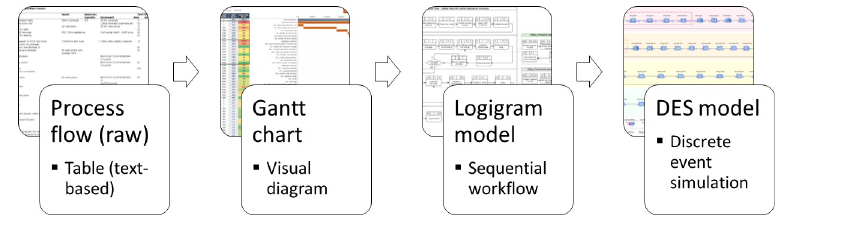
Fig 2. Overview of the modeling